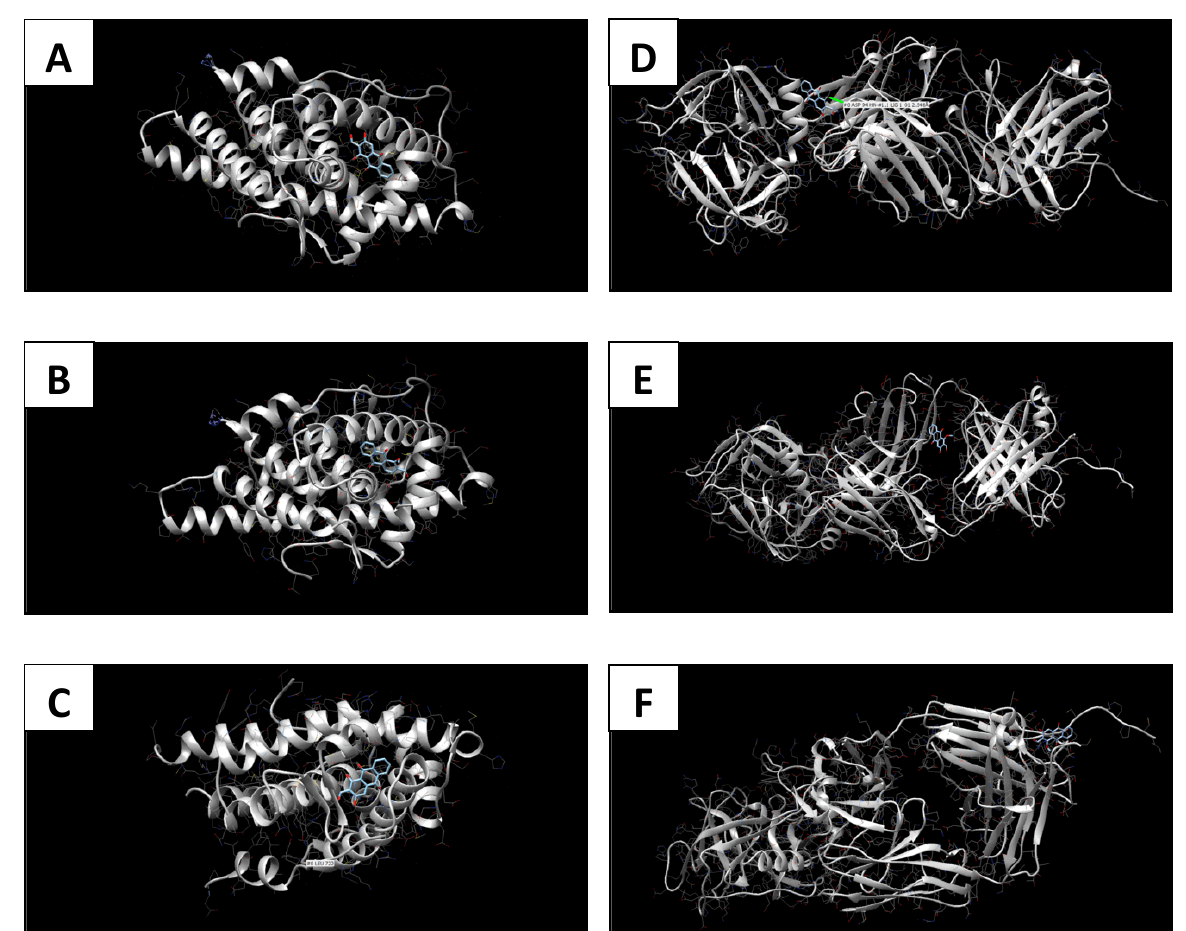
Figure 2. Molecular docking of damnacanthal with androgen receptor (AR) PDB codes: 3RLJ (A), 5T8J (B), 5VO4 (C), and protein specific antigen (PSA) PDB codes: 2ZCH (D), 2ZCK (E), 2ZCL